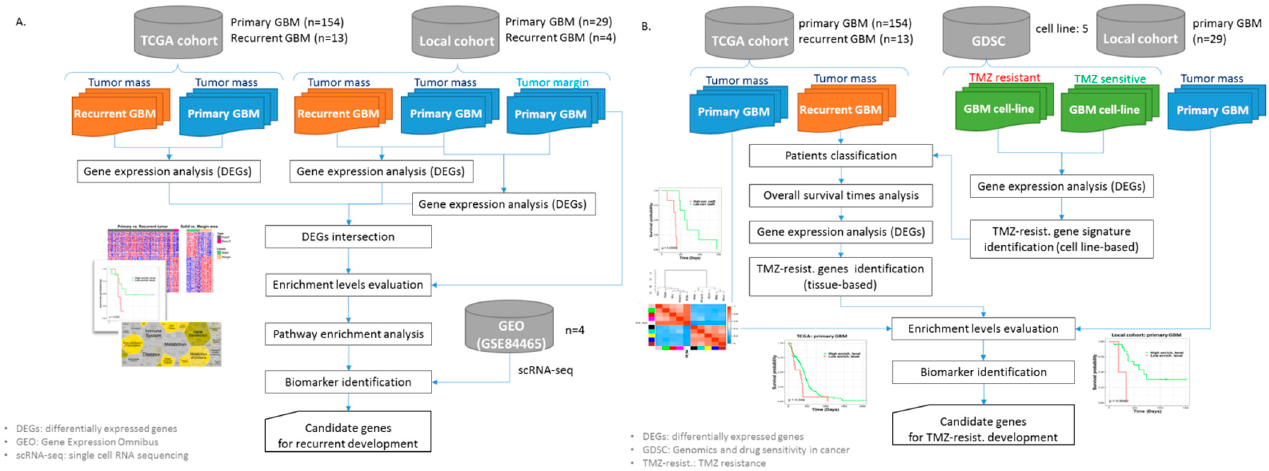
Figure 1. The analysis workflows in the study. ( A ) The workflow of identification of genes related to development of recurrent GBM. ( B ) The workflow of identification of genes related to development of TMZ resistance.